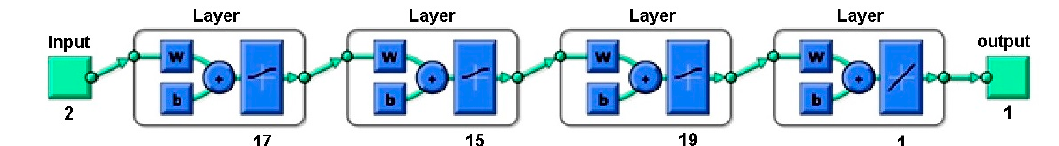
Figure 11. A proposal block diagram of Sn-Zn-Cu alloys using ANN.